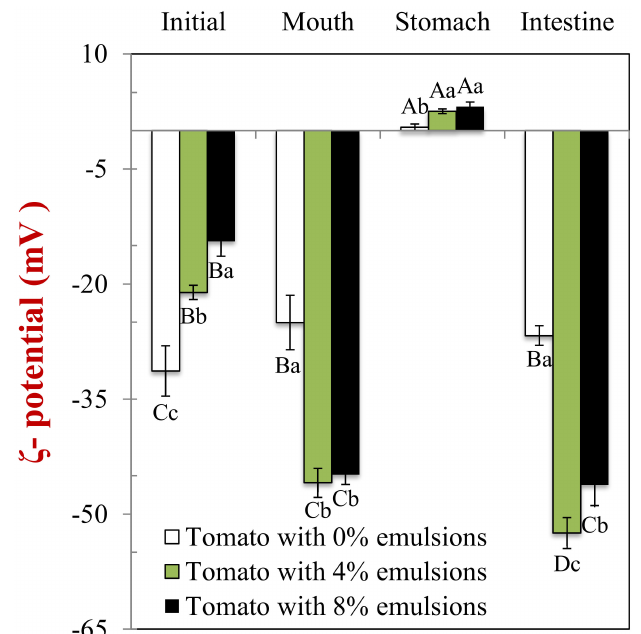
Figure 4. The electrical characteristics ( ζ -potentials) of samples containing di ff erent lipid content. Samples designated with upper-letters ( A , B , C ) were significantly di ff erent (Duncan, p < 0.05) when compared between di ff erent GIT conditions (same lipid content). Samples with di ff erent lower-case letters (a, b, c) were significantly di ff erent (Duncan, p < 0.05) when compared between di ff erent lipid content (same GIT